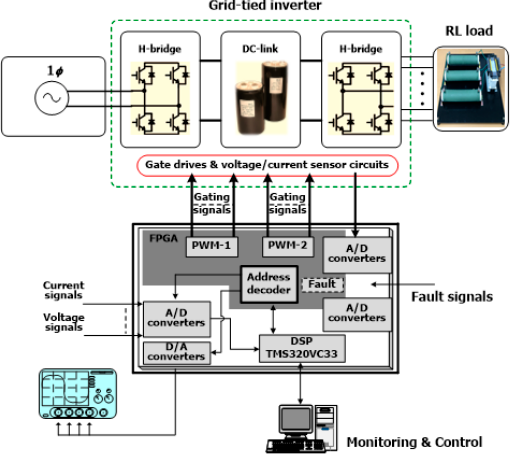
Figure 8. A block diagram of the experimental set-up for a single-phase grid-tied inverter system.